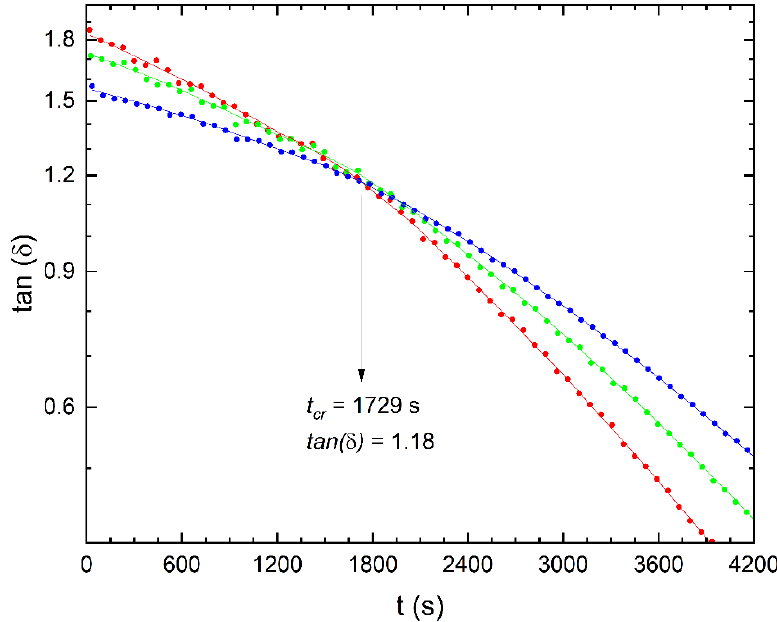
Figure 2. The loss tangent, tan ( δ ), as a function of the reaction time during the Diels–Alder click reaction between N -furfuryl chitosan (21% degree of substitution) and PEG(mal) 2 -7500 at 50 °C. The tan ( δ ) curves at different frequencies crossover at the gel point ( ω = 2.15, 4.64 and 10 rad · s − 1 ; red, green, and blue, respectively). Polymer concentration: 1 wt.%, and R = 0.25. Table 2. Critical gel times and the strength of the hydrogel at gelation for the system between N -furfuryl chitosan (1%- w / w ) and PEG(mal) 2 -7500 with R = 0.25. T gel ( ◦